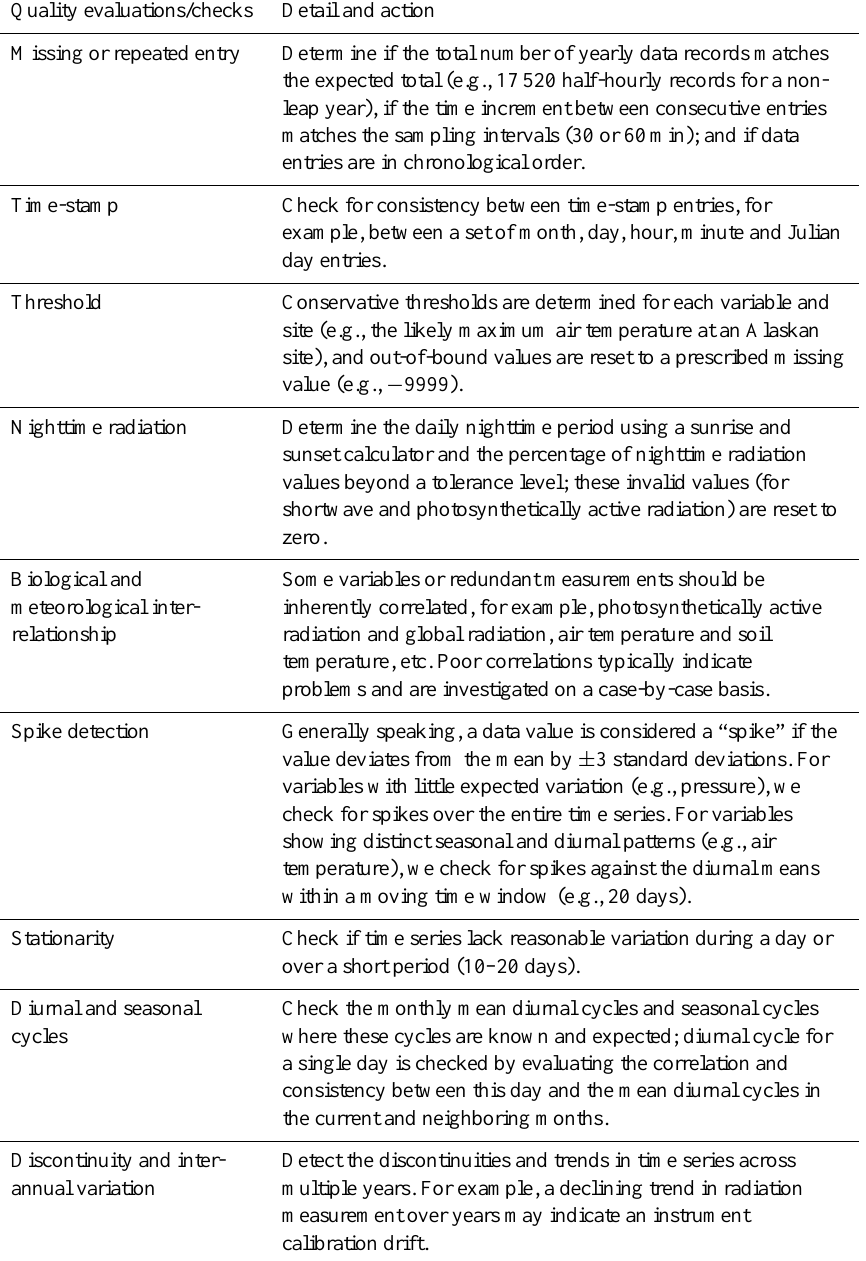
Table 2. Quality evaluations and checks performed by CDIAC on incoming meteorological and flux data